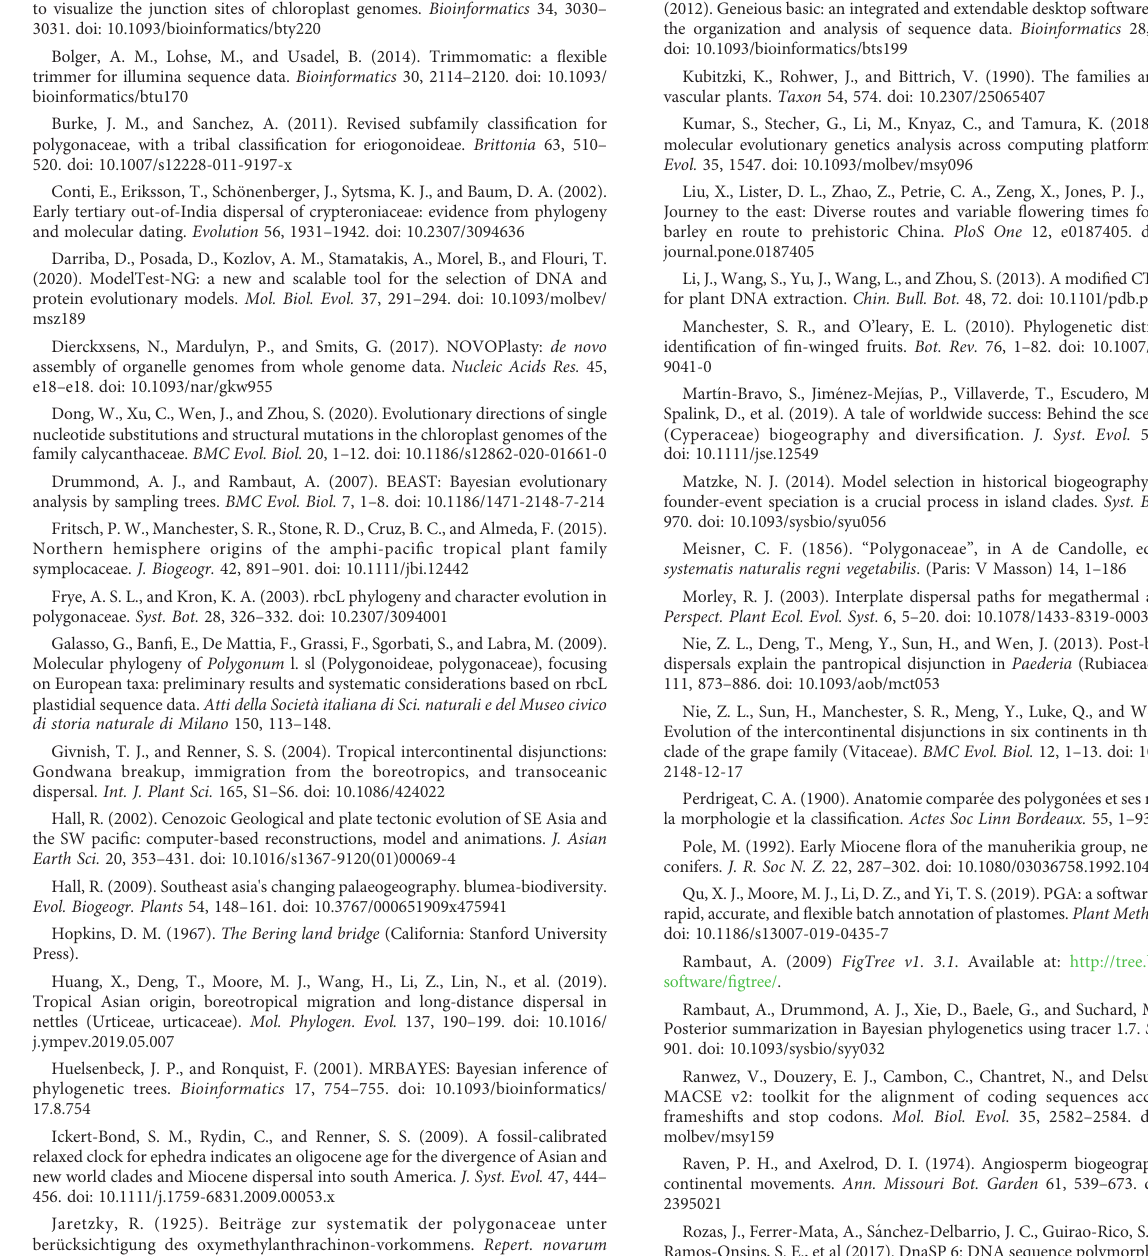
SUPPLEMENTARY FIGURE 3 Phylogenetic tree of 60 taxa using maximum likelihood (ML) and Bayesian inference (BI) based on three chloroplast fragments ( matK , trnL and rbcL